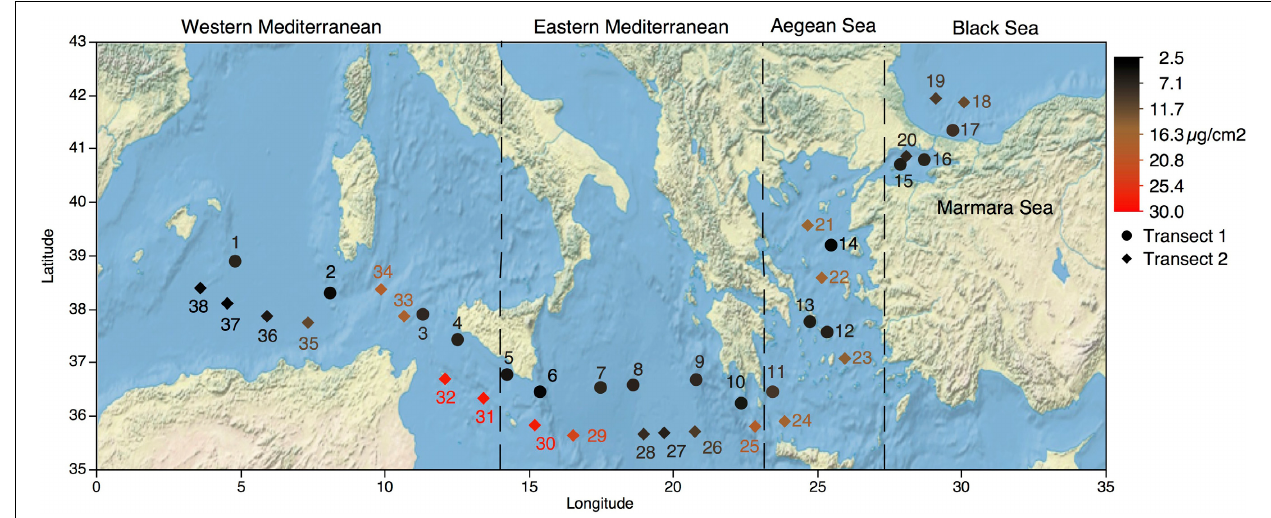
FIGURE 1 | Location of the sampling sites along the Mediterranean Sea. Color scale indicates bulk aerosol concentrations from satellite observations